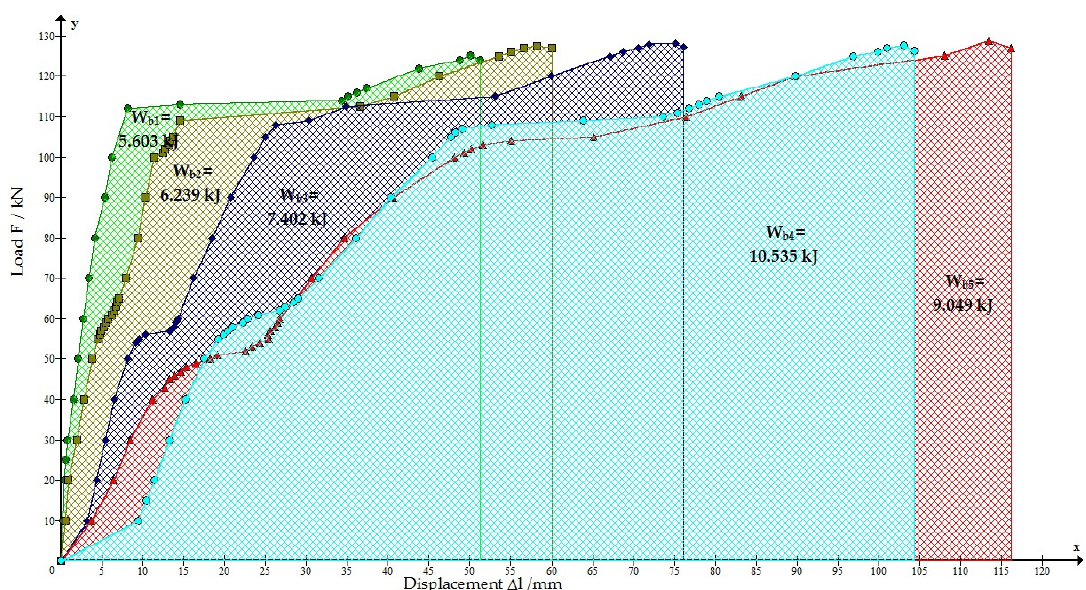
Figure 13. Work done by a 1.6 m-long rock bolt support equipped with the sleeve mechanical head with bearing plate: W b1 —flat; W b2 —dome; W b3 —two domes; W b4 —four domes; W b6 —six domes.